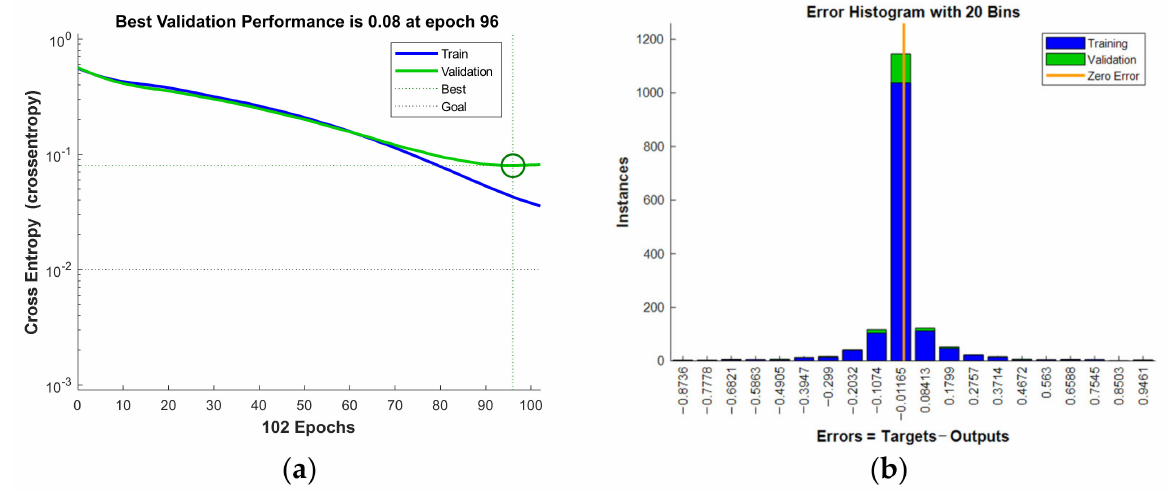
Figure 11. The 10-fold misclassification rate and error histogram results of the grid search method. Micrographs shown in ( a , b ) are views of the misclassification rate and error histogram with 20 bins.